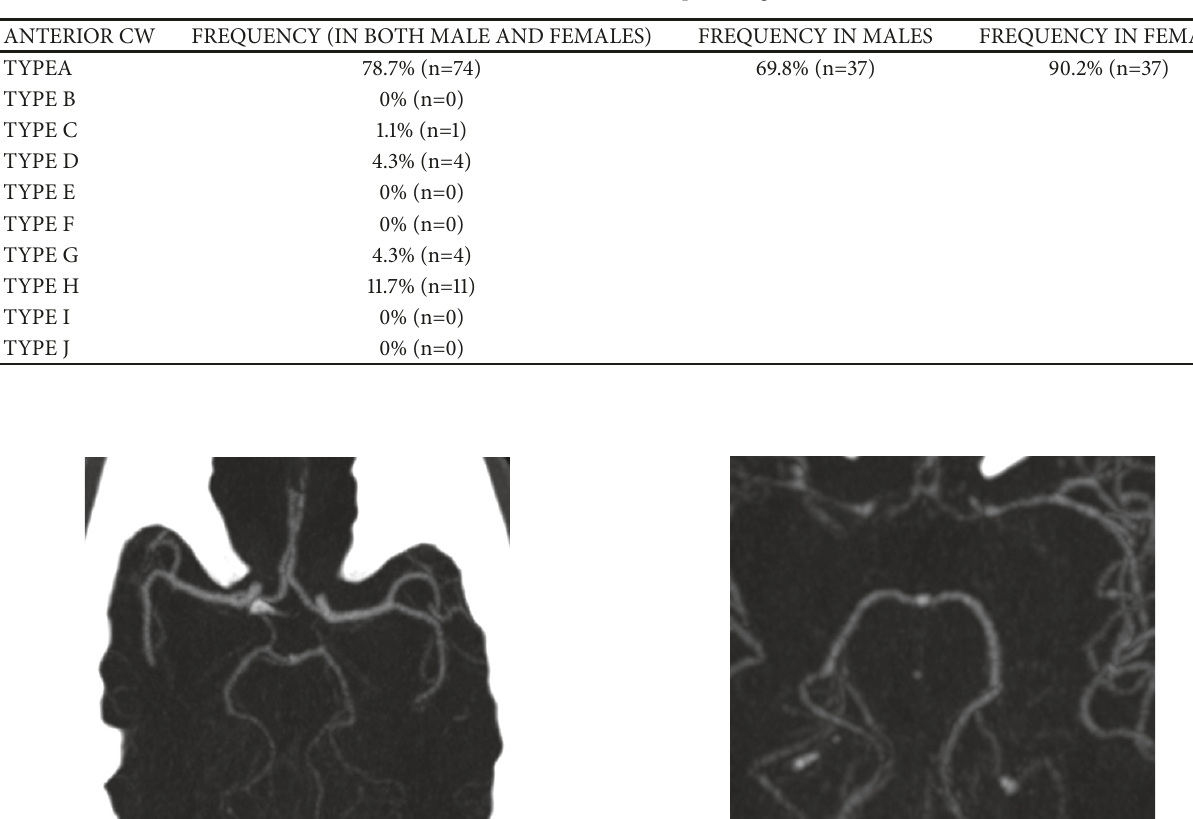
Table 2: Anterior circulation variant percentage distribution.